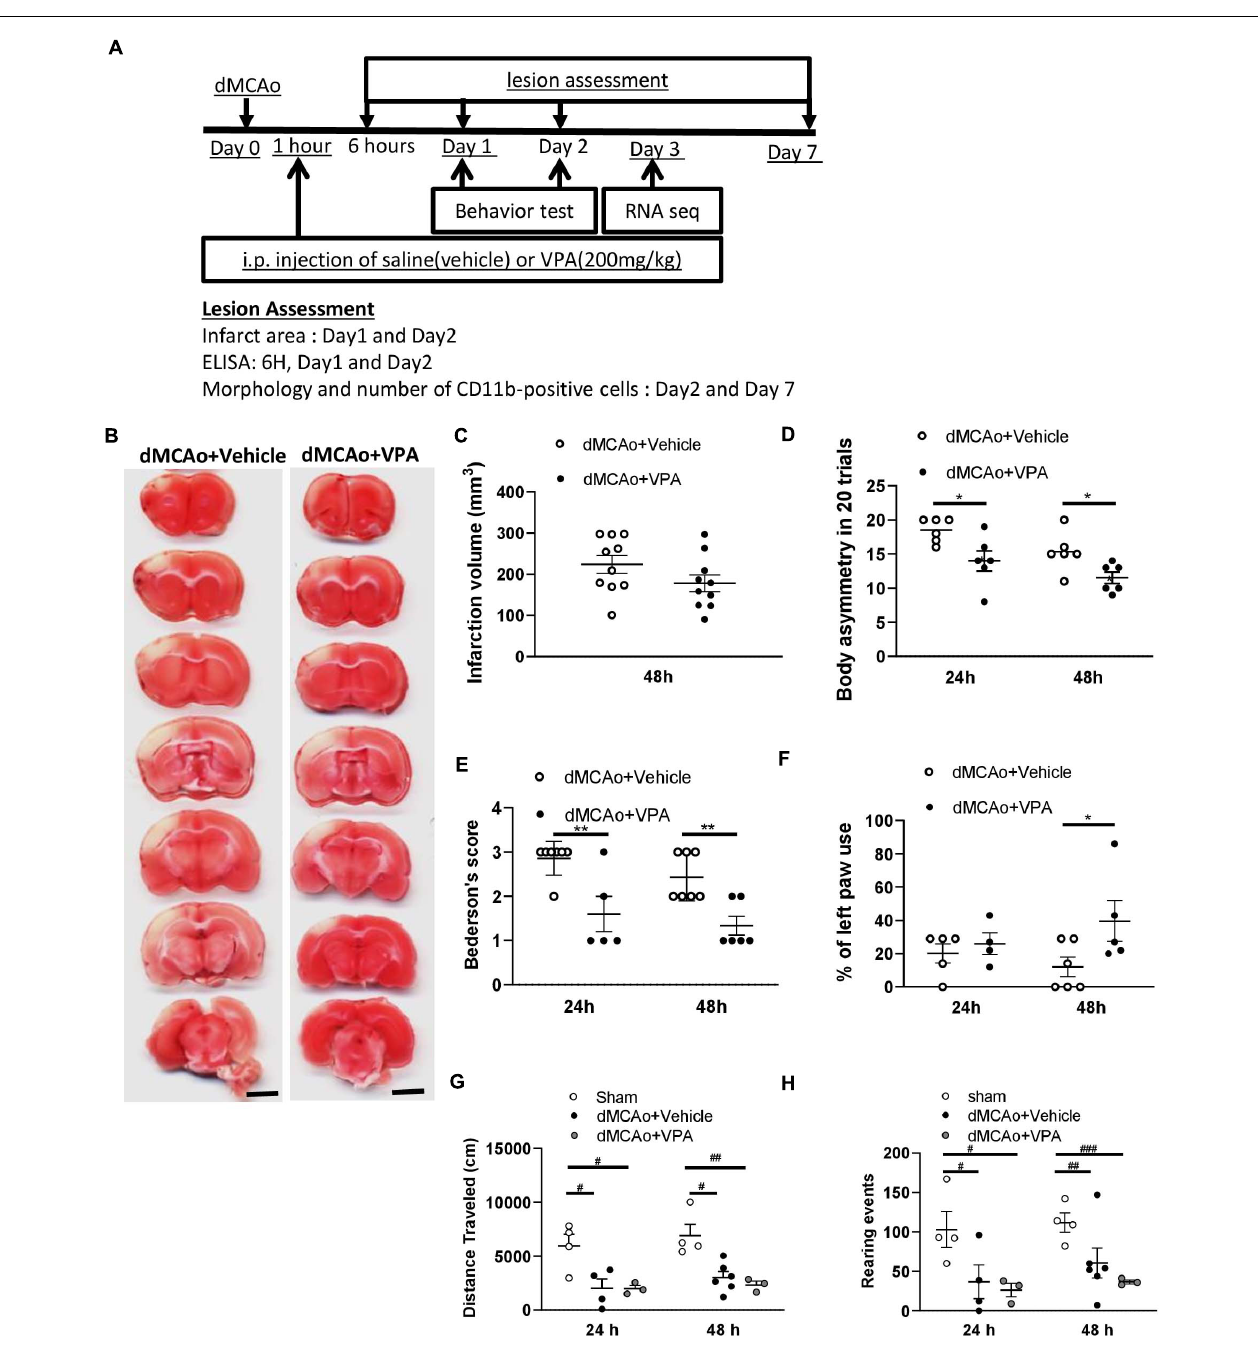
FIGURE 1 | Post-stroke single injection of VPA (200 mg/kg) does not reduce infarct area, but promotes functional recovery. (A) Experimental timeline. The rats underwent dMCAo surgery, and they were divided into two groups randomly. One hour after reperfusion, the animals received an intraperitoneal injection of either VPA or vehicle once, and their behavioral functions were evaluated on day 1 and 2. Rats were sacrificed for analysis at different time points. (B) A representative image showing infarct area stained with TTC in a series of coronal sections derived from these two groups of rats killed at 48 h after ischemia. (C) Quantified results of infarct volumes derived from animals killed at 48 h after the onset of dMCAo. (D,E) Effects of VPA ( n = 7), vehicle ( n = 8) on body asymmetry (D) , Bederson’s neurologic test score (E) , * p < 0.05, ** p < 0.01 indicate comparison with vehicle with Bonferroni’s post hoc test following two-way ANOVA. (F) Forepaw use bias of the rats was assessed using the cylinder test on day 1 and 2 after dMCAo. * p = 0.039 by Bonferroni’s multiple comparisons test, following two-way ANOVA. (G,H) Effects of VPA ( n = 5), vehicle (n = 6), and no treatment ( n = 4) on vertical (G) and horizontal (H) activity measured for 30 min on day 1 and 2. * p < 0.05, ** p <